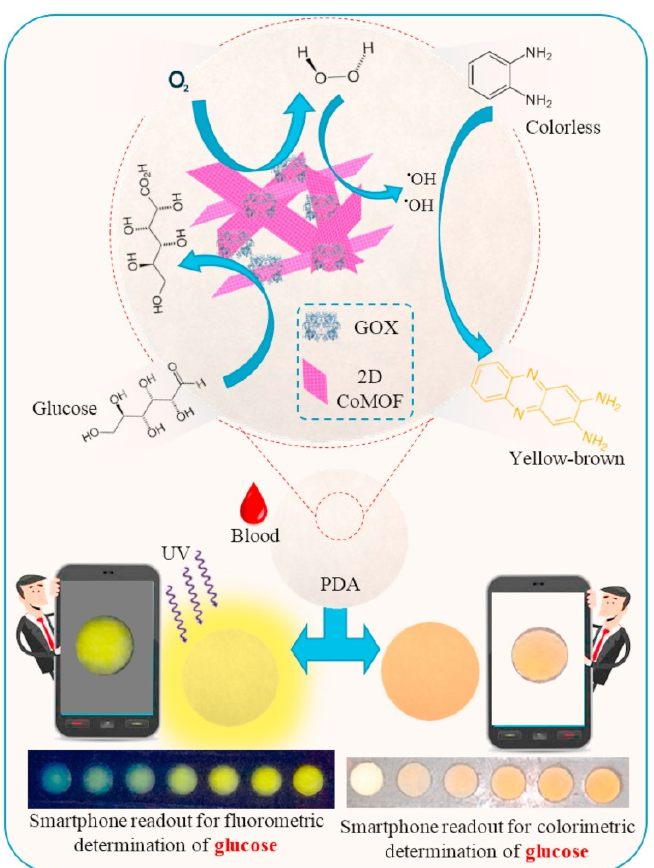
Figure 14. Fluorometric and colorimetric glucose detection by a bi-functional 2D Co-MOF. Reprinted from [121], with permission from Elsevier.